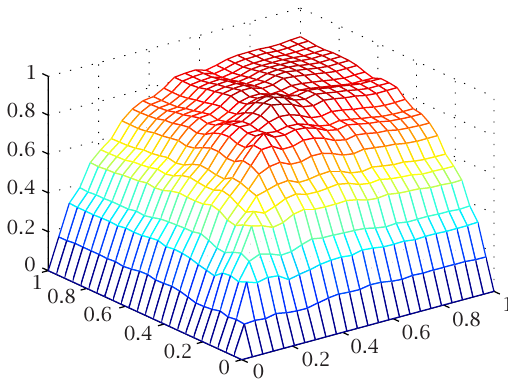
Figure 1.1 . Sample covariance kernel, where 0 ≤ x ≤ 1, 0 ≤ y ≤ 1, and z = R(x,y)